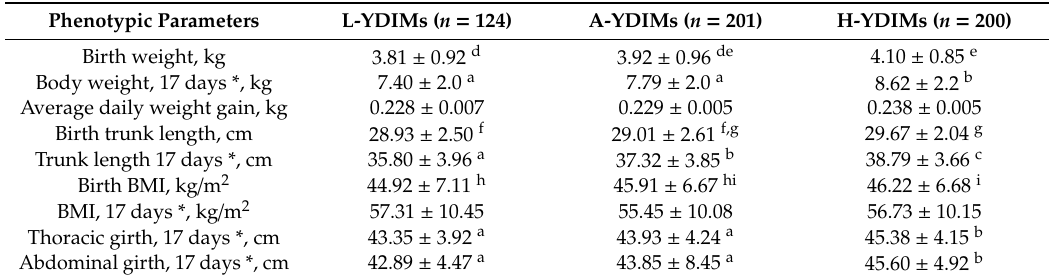
Table 5. Phenotypes of lambs born to high-, average-, or low-yielding ewes. Phenotypic Parameters